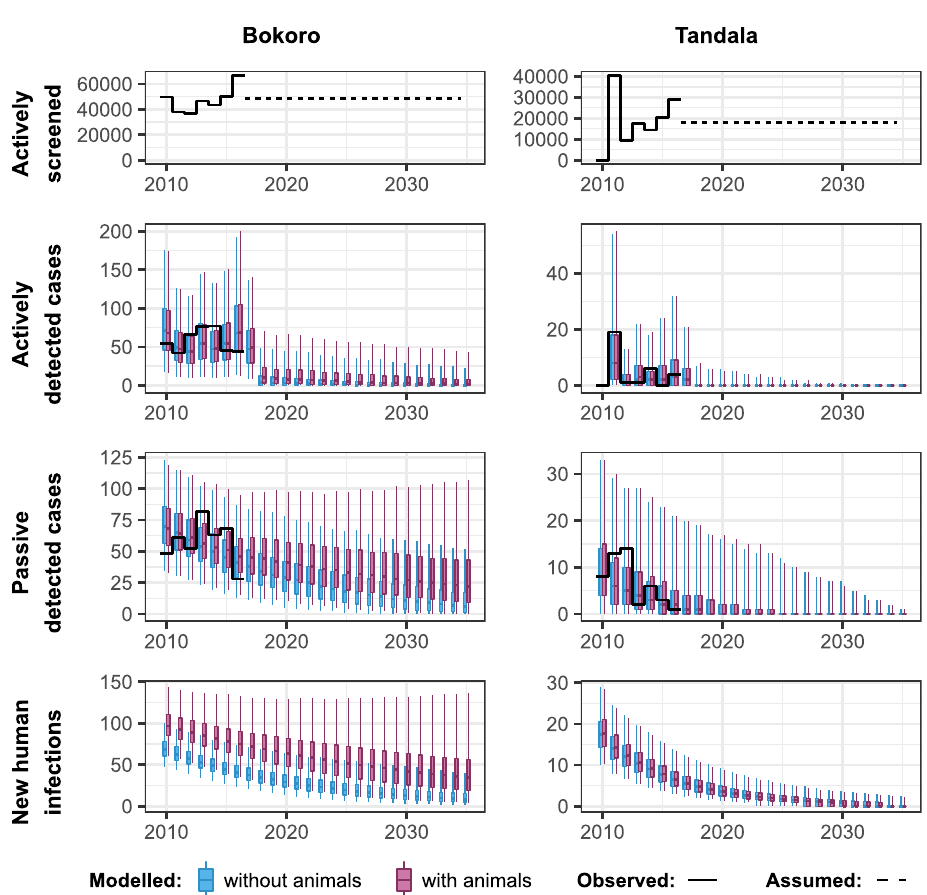
Fig 6. Forward projections for Bokoro and Tandala health zone for models with and without animals contributing to gHAT transmission. Within each health zone, future AS is assumed to be at the average level of screenings from 2012–2016, while PS continues at the 2016 level of effectiveness. In Bokoro, and other health zones in the former province of Bandundu, the specificity of AS was assumed to increase to 100% in 2018 due to video